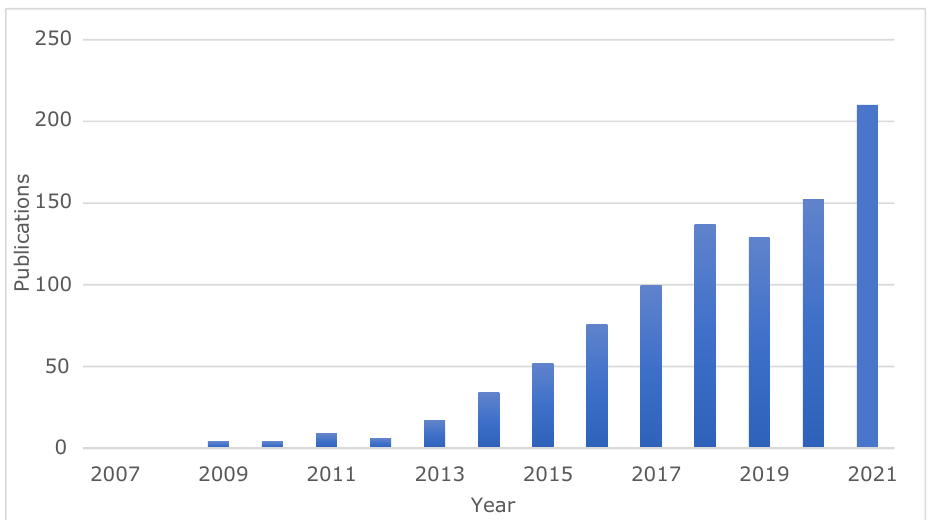
Figure 1. Evolution of sustainability and resilient microgrids in the